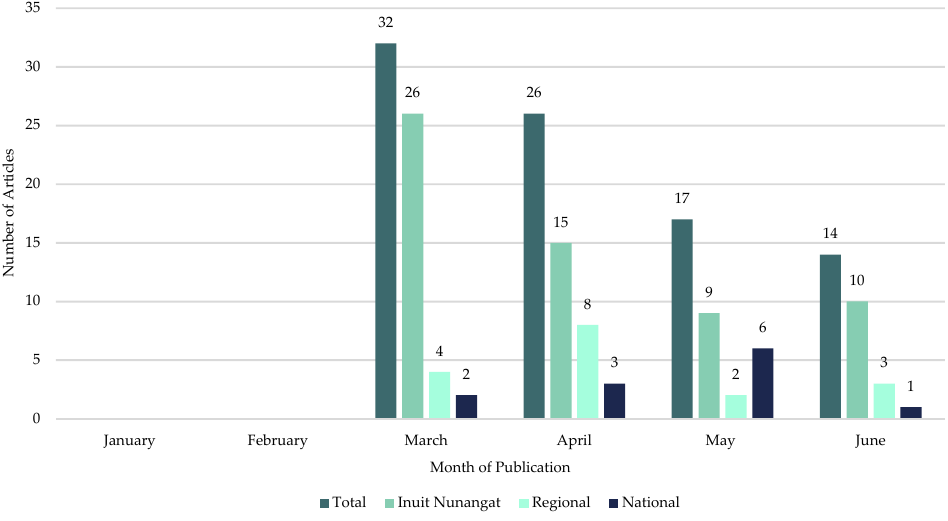
Figure 3. Month of publication, by region, of included articles on the mining industry’s initial response to COVID-19 in Inuit Nunangat from 1 January 2020, to 30 June 2020. Inuit Nunangat-based newspapers published 67% (n = 60 articles) of all included articles (Figure 4). Regional newspapers located mostly in southern Canada (10 provinces)